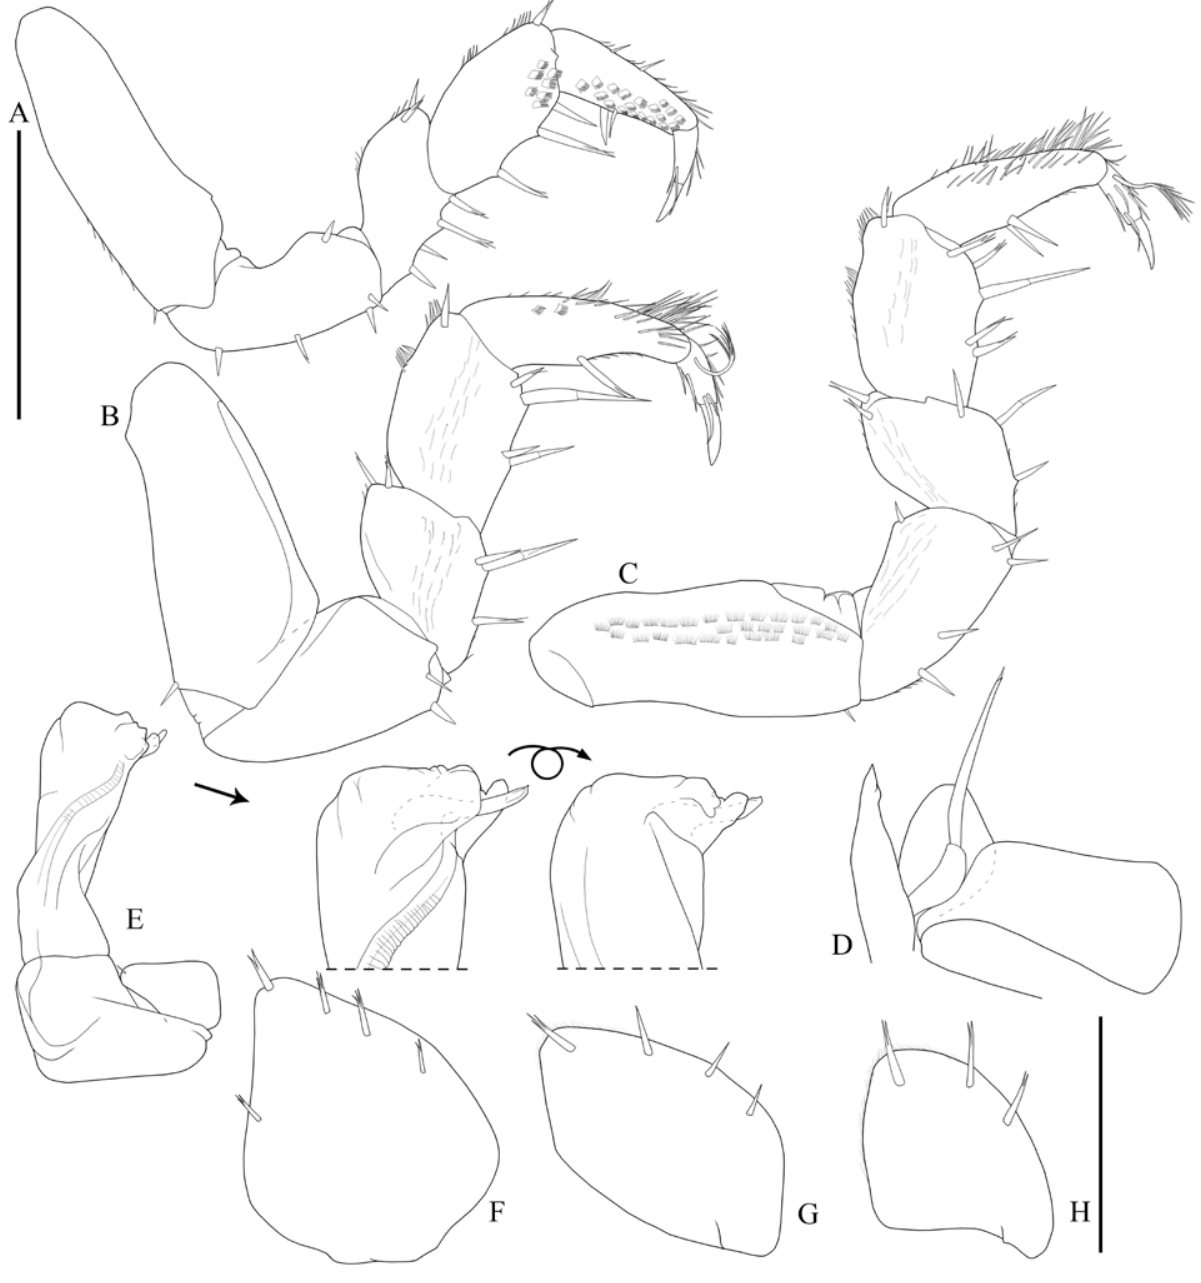
Figure 18. Pectenoniscus morrensis n. sp. Male paratype: A , pereopod 1; B , pereopod 6; C , pereopod 7; D , genital papilla and pleopod 1; E , pleopod 2; F , pleopod 3 exopod; G , pleopod 4 exopod; H , pleopod 5 exopod. Scale bars: 0.2